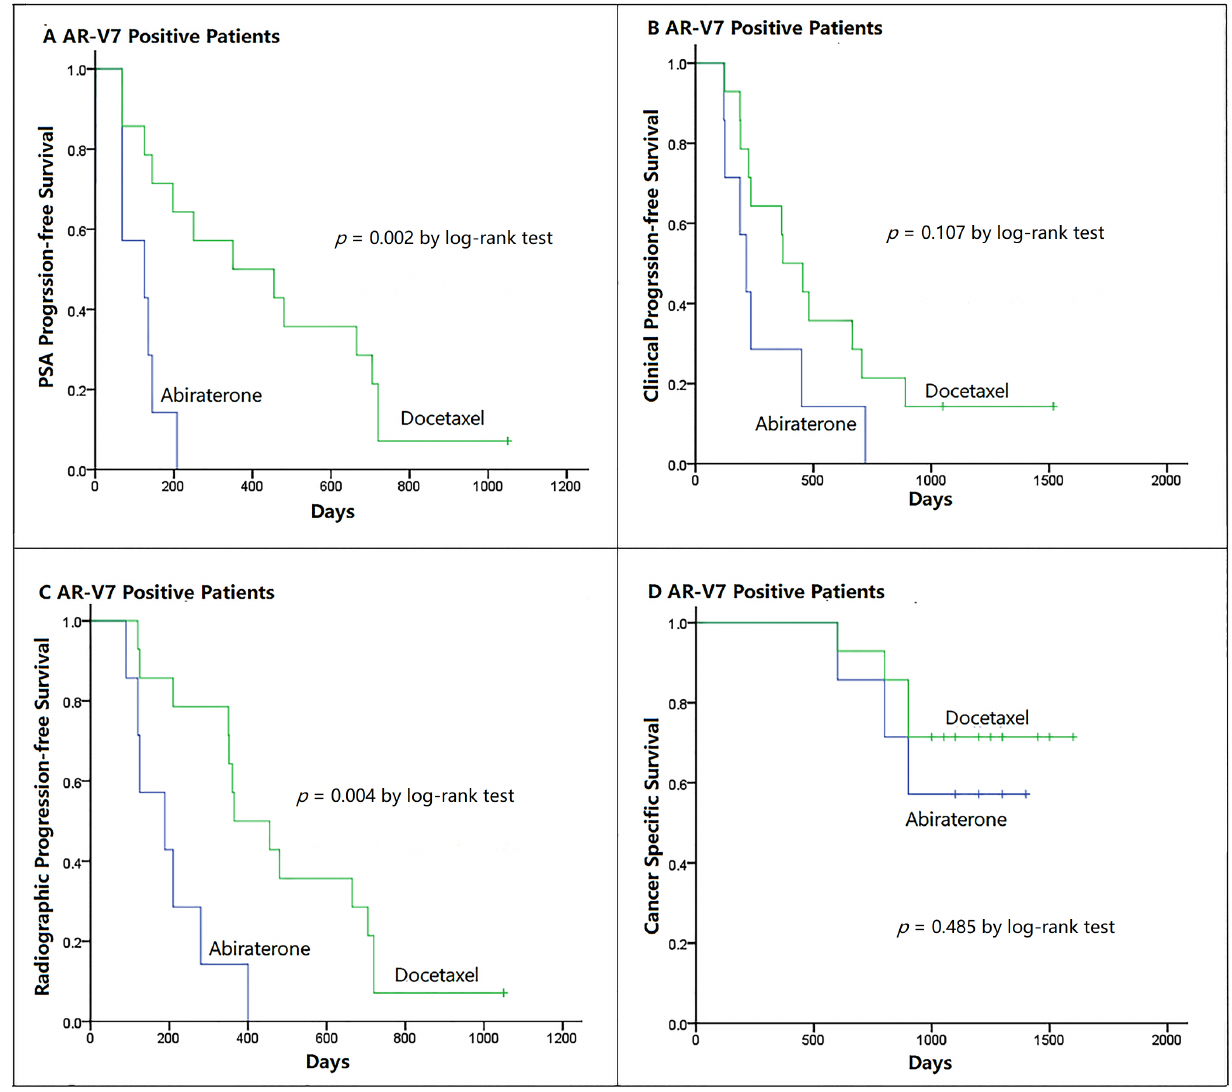
Fig. 2. Kaplan–Meier analysis and comparison of PSA PFS, clinical PFS, radiographic PFS and CSS between Doc and Abi. (A) PSA PFS of docetaxel (Doc)-treated patients was longer than Abi by log-rank test, p = 0.002. (B) No significant difference in clinical PFS between Doc and Abi by log-rank test, p = 0.107. (C) Radiographic PFS of Doc-treated patients was longer than Abi by log-rank test, p = 0.004. (D) No significant difference in CSS between Doc- and Abi-treated patients by log rank test, p =